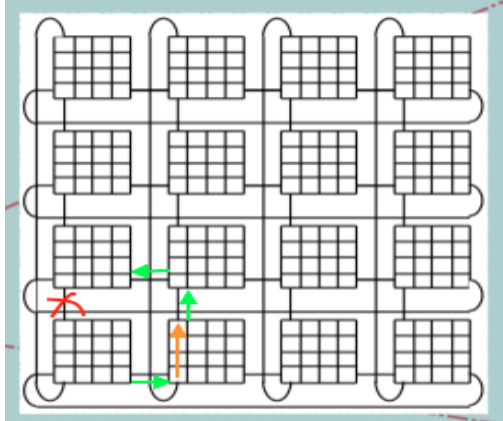
Figure 4. Link failure at Level-2 network of TFBN between the nodes(0,0) and (1,0). The message can be routed via the nodes(0,1) and (1,1) instead of the faulty